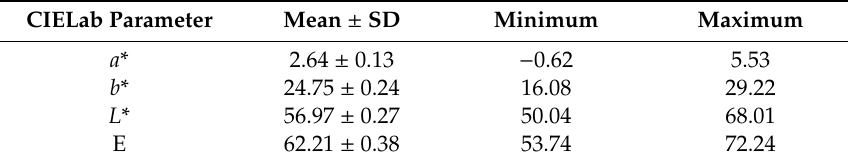
Table 2. CIELab parameters for potato crisps.